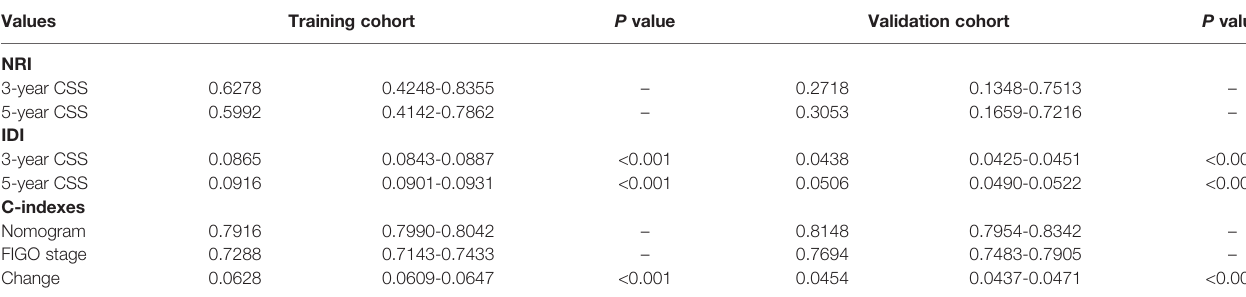
TABLE 4 | Value of the NRI, IDI, and C-indexes of the nomogram and FIGO staging system in both the training and validation cohorts.